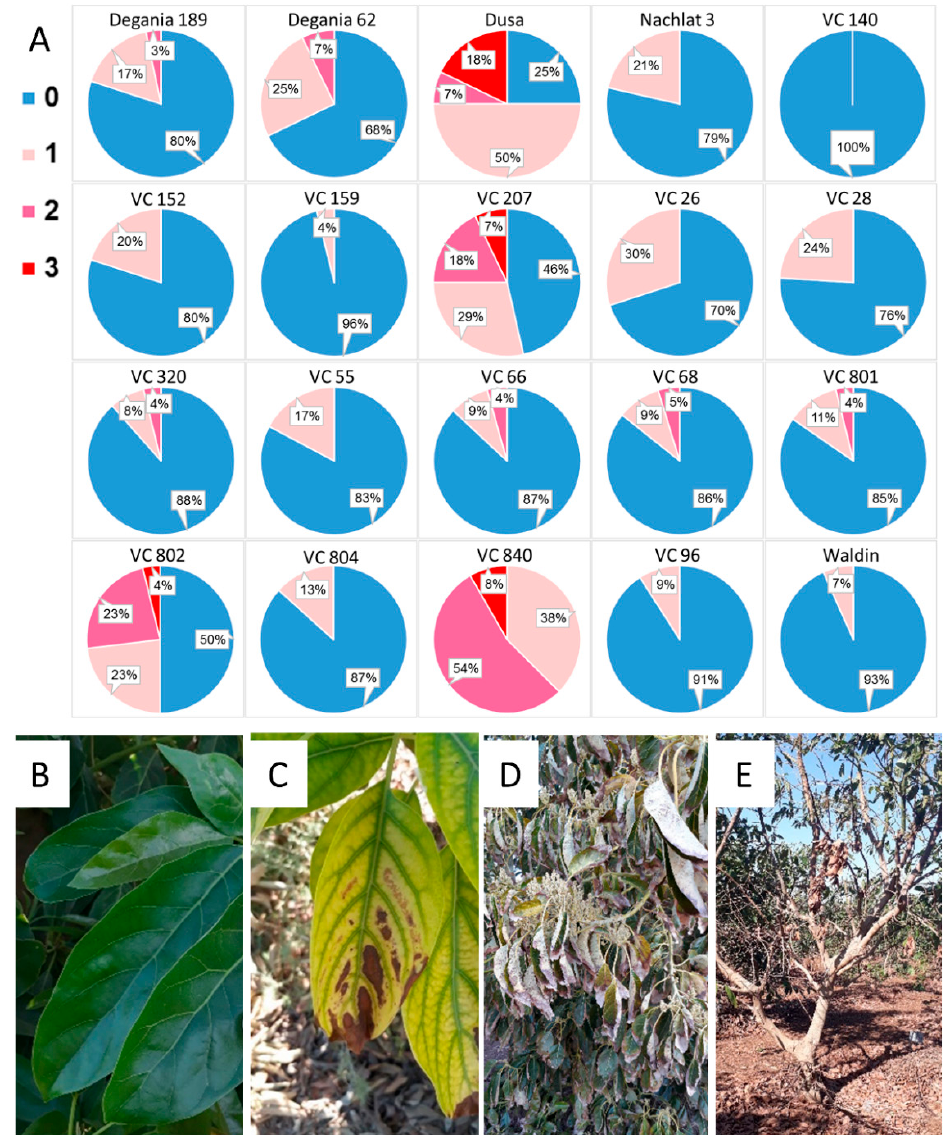
Figure 2. Salt damage in the orchard after a year of irrigation with water high in salt. ( A ): visual survey. ( B ): healthy avocado leaves. ( C ): leaf necrosis. ( D ): severe leaf burns. ( E ): defoliation. In the survey, blue (0) represents no visual salt damage and pink/red shades (1–3) represent salt damage in increasing severity, from light necrosis to tree defoliation.